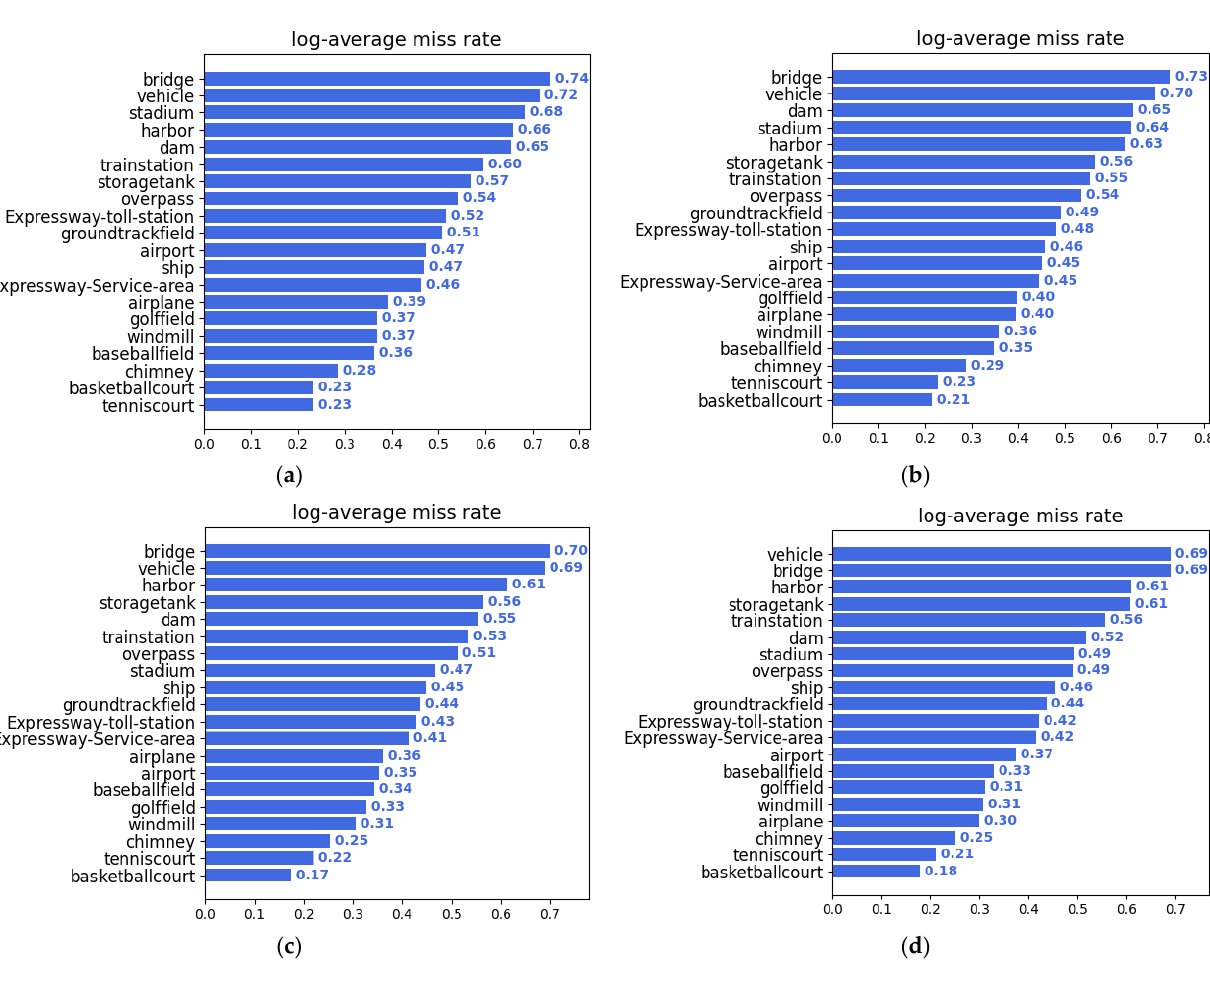
Figure 9. Log-average miss rate of each model. ( a ) Baseline; ( b ) Baseline + DHead; ( c ) Baseline + GFIC + DHead; ( d ) MFICDet.